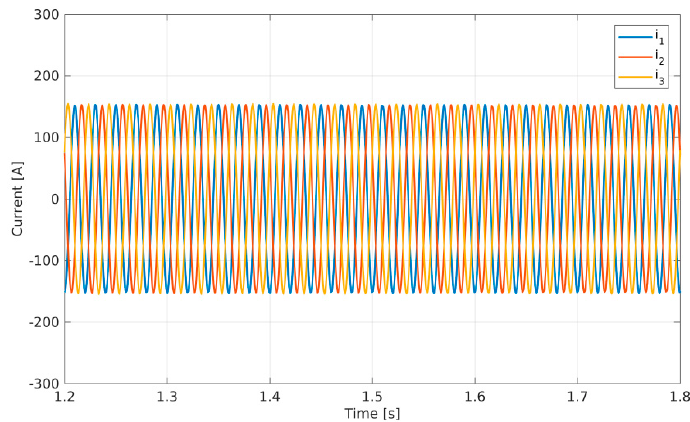
Figure 9. Three-phase currents with a voltage sag of 30%.